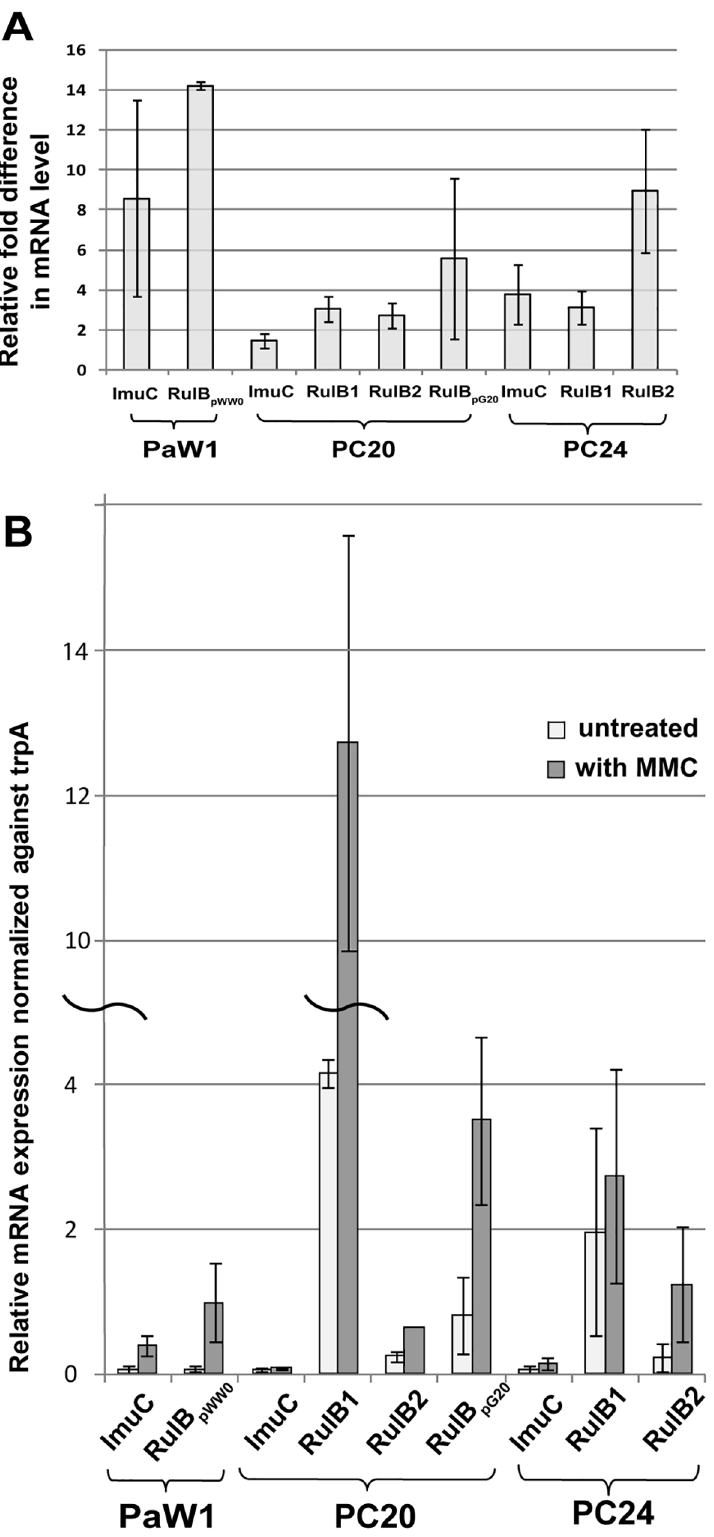
Fig 5. The expression rate of the genes of error prone DNA polymerases after the exposure of cells to DNA damaging agent MMC (2 μ g/ml). (A) The results are presentedas relative fold difference betweencells